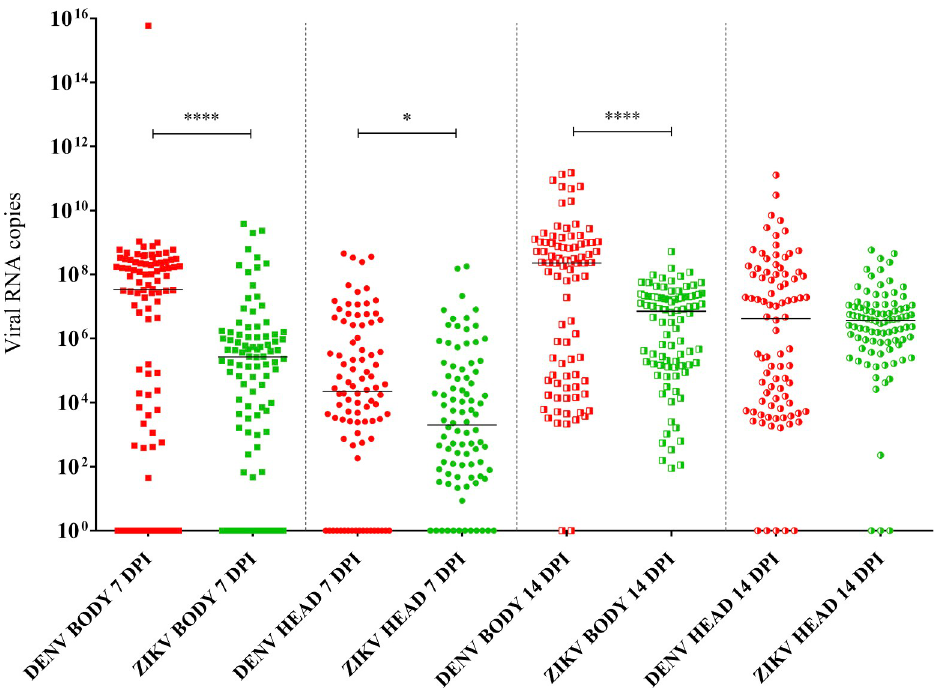
Fig 7. DENV (red) and ZIKV (green) viral loads for the total Ae . aegypti population of Belo Horizonte. The DENV total viral load in the body and head/salivary gland (SG) at 7 days post-infection (dpi) and in the body at 14 dpi is greater than the respective ZIKV total viral loads. At 14 dpi, the DENV total viral load in the head/SG is similar to that of ZIKV total viral load. Fully filled and half-filled squares represent viral load in the mosquito bodies at 7 and 14 dpi, respectively. Fully filled and half-filled circles represent viral load in the mosquito head/SG at 7 and 14 dpi, respectively. P values > 0.05 (not significative) are not represented. P values � 0.05, � 0.01, � 0.001, � 0.0001 are summarized with one, two, three, and four asterisks,